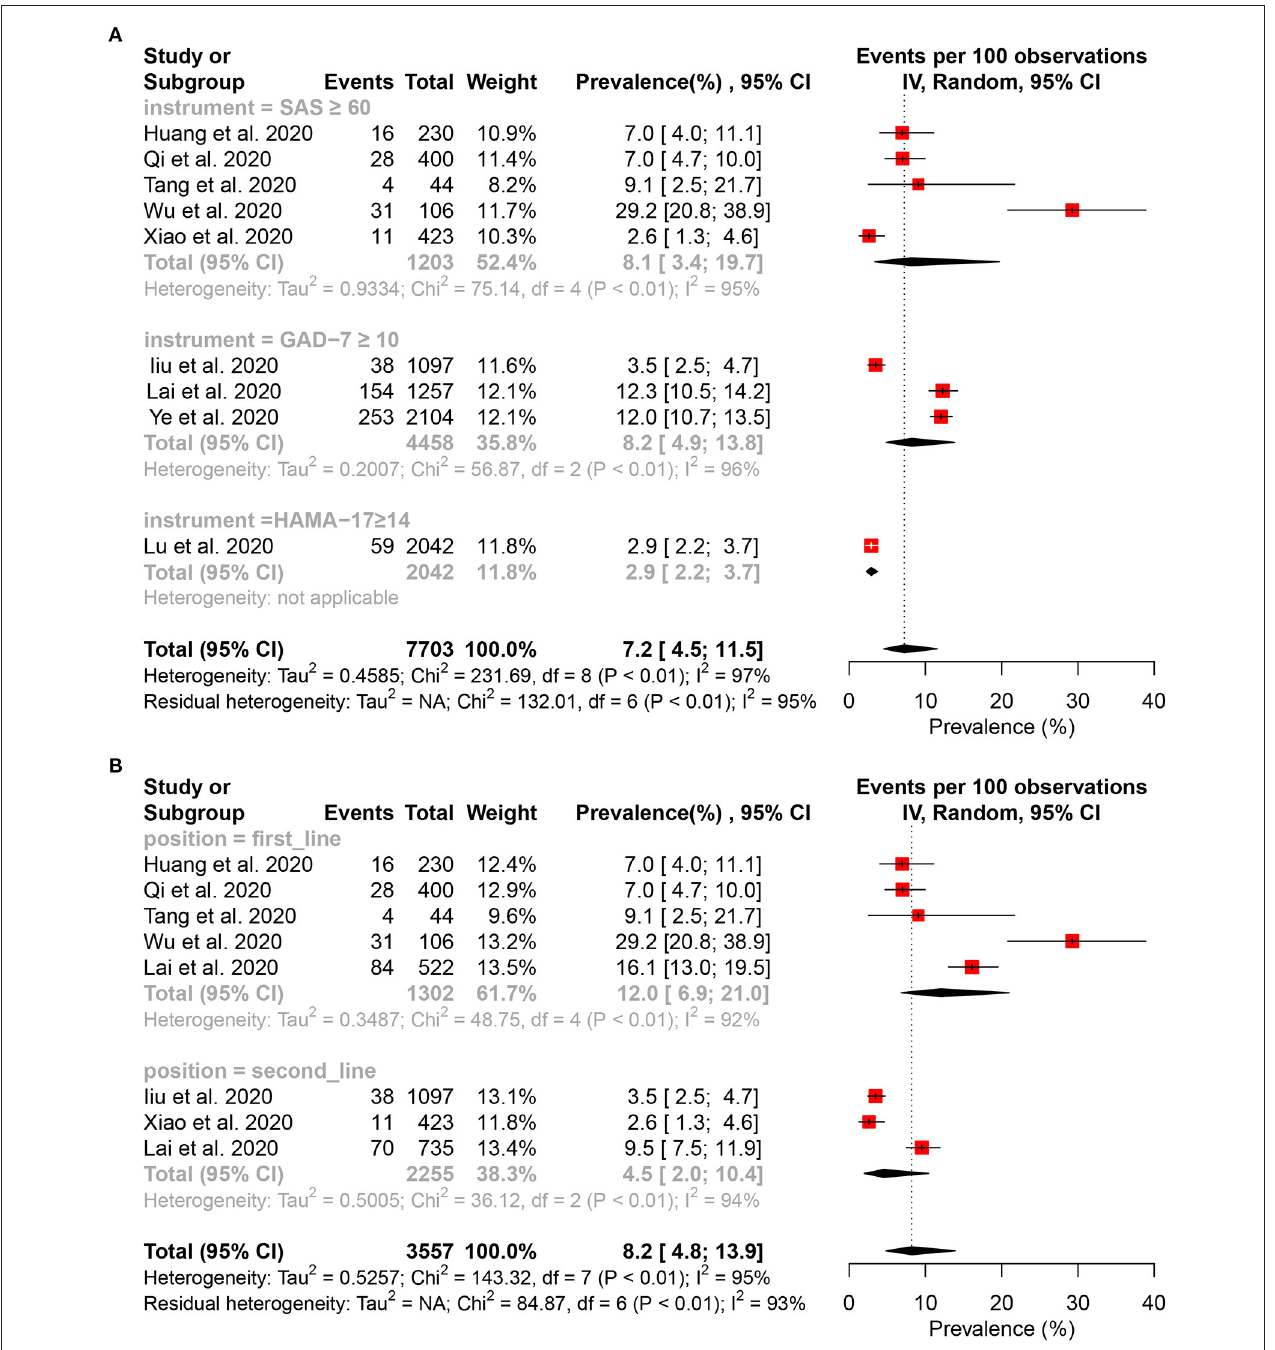
FIGURE 6 | Forest plot for the meta-analysis of the prevalence of moderate to severe anxiety and subgroup analysis among healthcare workers. (A) Forest plot of the prevalence of moderate to severe anxiety. (B) Forest plot of moderate to severe anxiety stratification by